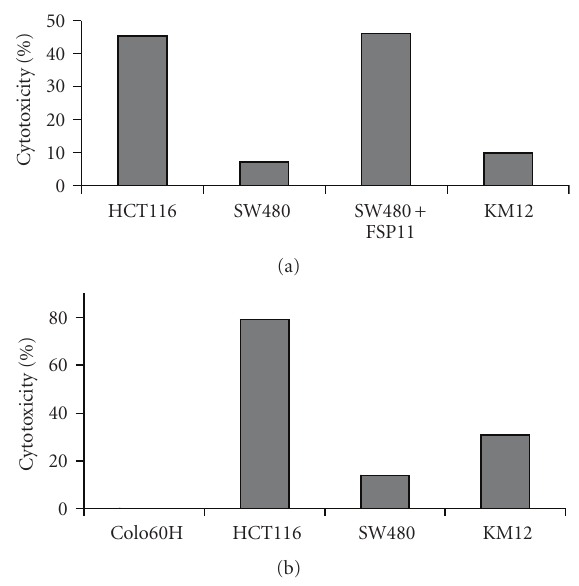
Figure 5: FSP11-specific T cells recognize tumor cell targets. T cell reactivity of the FSP11-specific (a) T cell bulk and (b) T cell clone C10/11 towards di ff erent tumor cell targets was tested at an e ff ector to target (E : T) cell ratio of 20 : 1. Targets tested were Colo60H, HLA-0201 (pos) / U79260(FTO) ( − 3); HCT116, HLA-0201 (pos) / U79260(FTO) ( − 4); SW480: HLA- 0201 (pos) / U79260(FTO) (wt) with and without addition of FSP11; and KM12: HLA-0201 (neg) / U79260(FTO) ( − 4). A representative experiment of three is shown. Analysis was performed after a 12- hour incubation